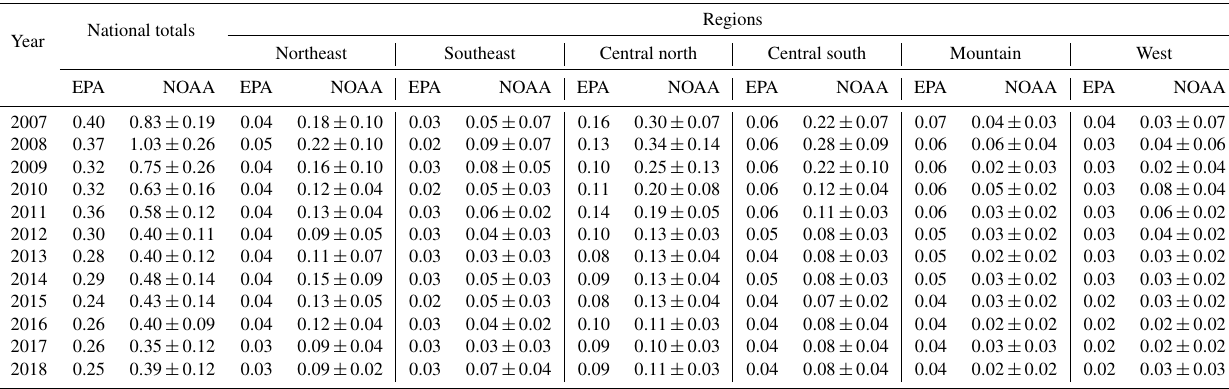
Table 1. US national and regional annual emissions of SF 6 (in Ggyr − 1 ) reported by EPA and derived from NOAA atmospheric measure- ments from this study. Errors derived from NOAA atmospheric measurements are expressed at a 95% confidence